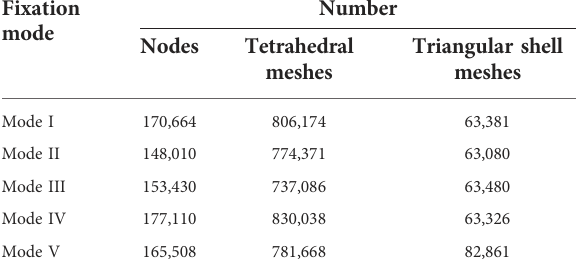
TABLE 1 Number of nodes and meshes in different